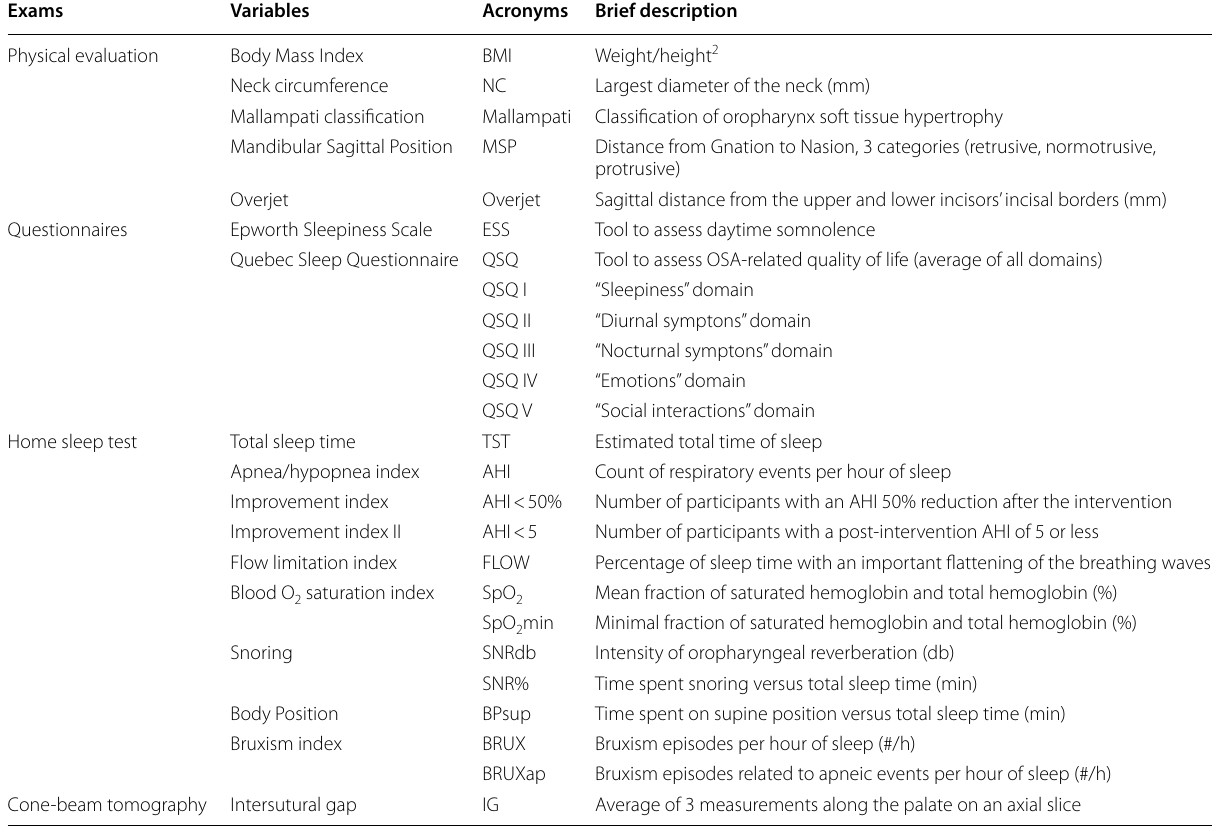
Table 1 Exams and corresponding variables